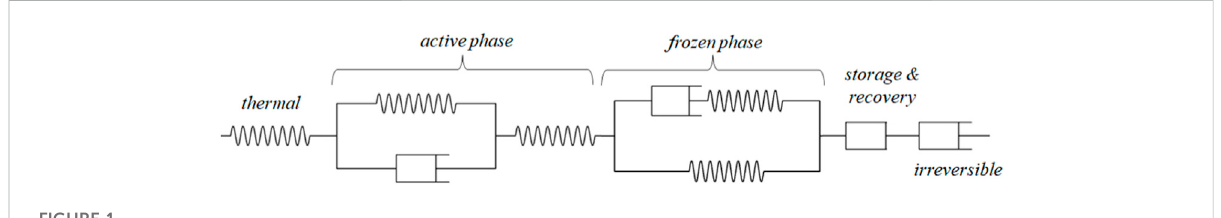
FIGURE 1 Linear rheological representation of multi-phase viscoelastic mixture analogy.